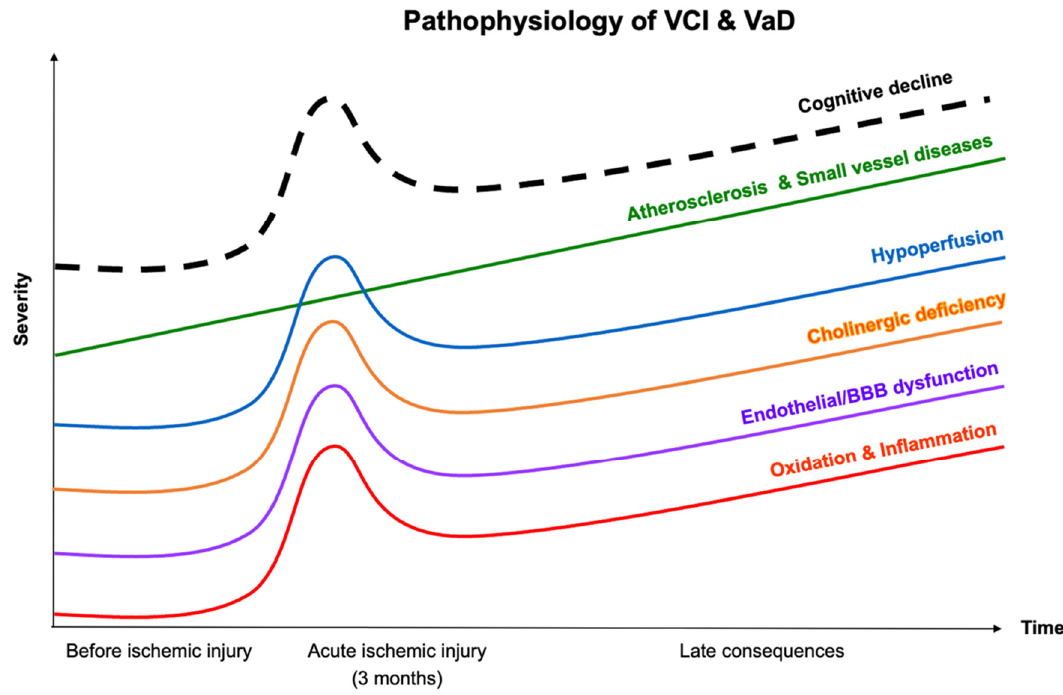
Figure 1. Progression of the pathophysiology of vascular cognitive impairment (VCI) or vascular dementia (VaD). BBB, blood–brain barrier .